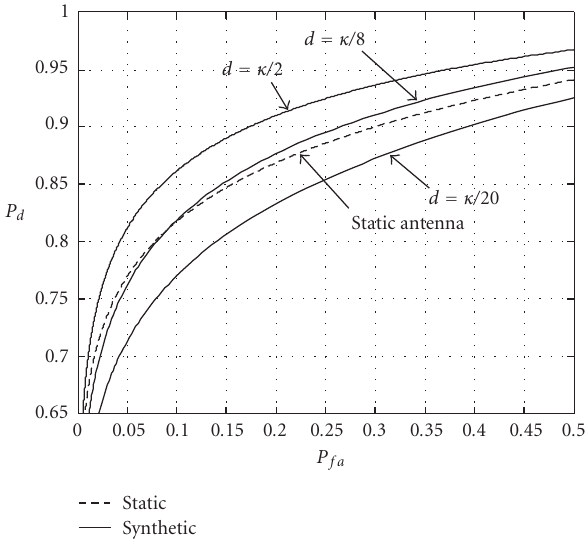
Figure 10: Numerically calculated ROC curves in an uncorrelated case.